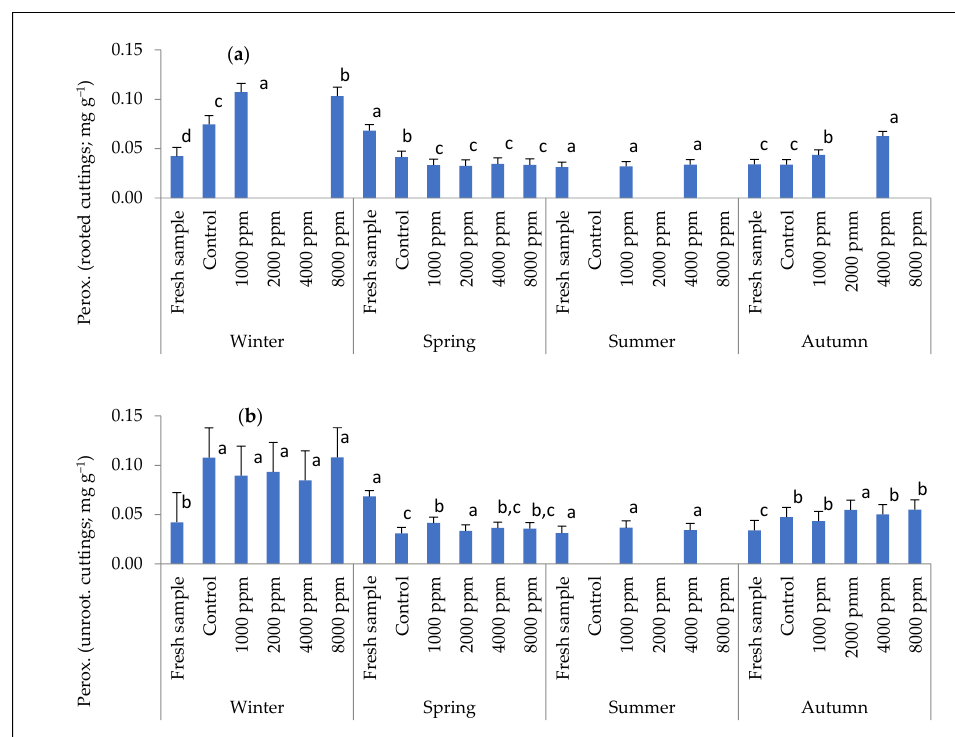
Figure 7. Mean peroxidase within seasons with different IBA treatments for ( a ) rooted and ( b ) unrooted cuttings. Mean values with the same letter were not significantly different at the 0.05 level (LSD test). Error bars: LSD intervals.